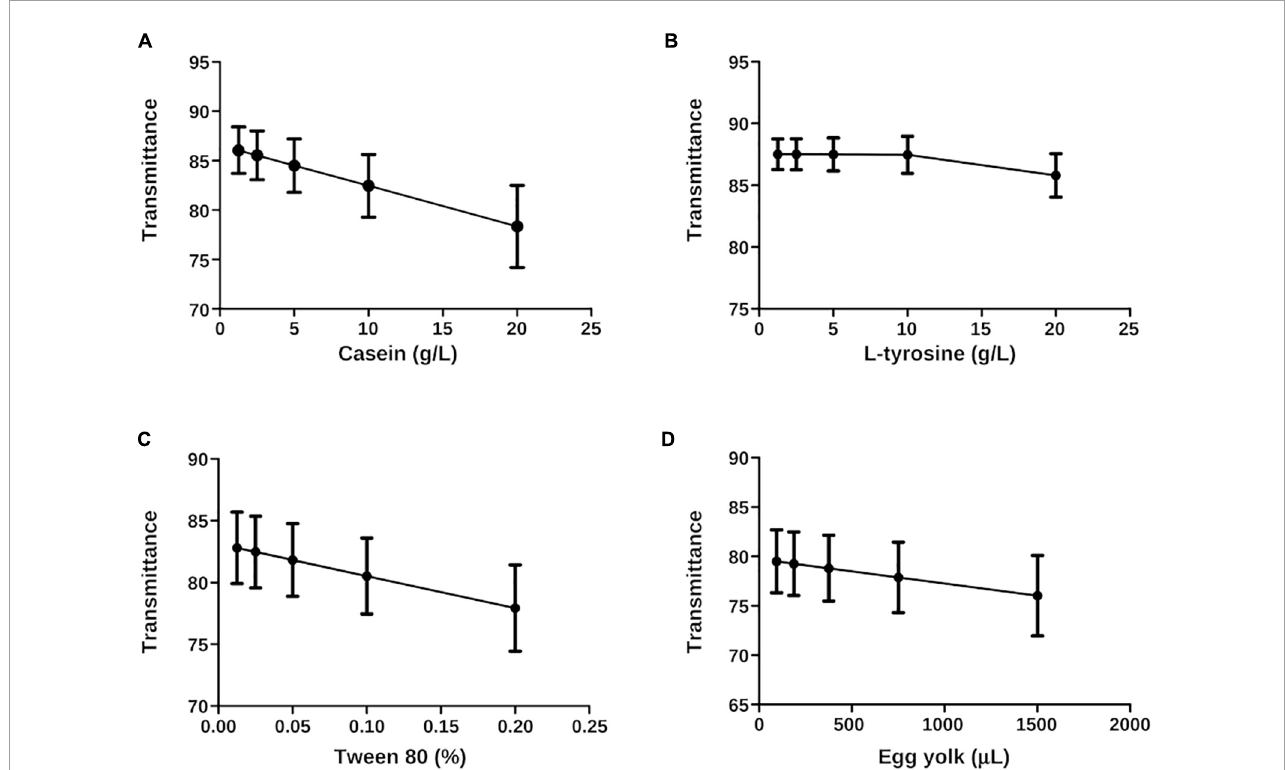
FIGURE8 Least squares plots (x, y) of N. brasiliensis hydrolyzates interpolated on the calibration curve. The best fit was calculated. (A) Casein has linear regression and a pronounced slope with an r 2 of 1.0. (B) L-tyrosine showed a feeble slope in the linear regression. Therefore, the r 2 value was 0.67. (C) Tween 80 had linear regression, slope, and an r 2 value of 1.0. (D) The egg yolk showed a linear regression. The slope was not as pronounced as the casein, and the r 2 of Tween 80, was 1.0. The plots were generated in GraphPad Prism